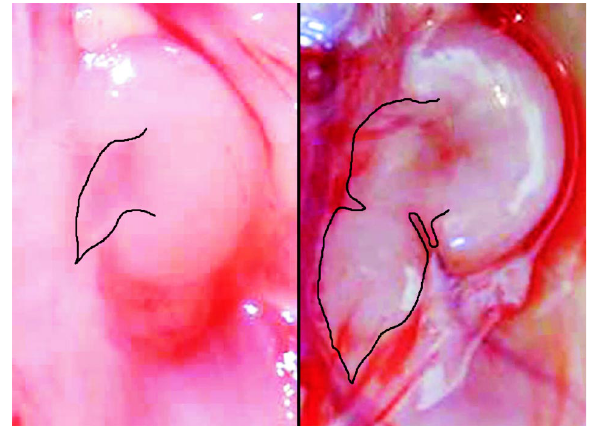
Figure 2 – Macroscopic comparison between a normal kidney from the control group (left) with hydronephrotic kidney from the adriamycin group (right). The ureters are delimited, showing dilation in the adriamycin group.